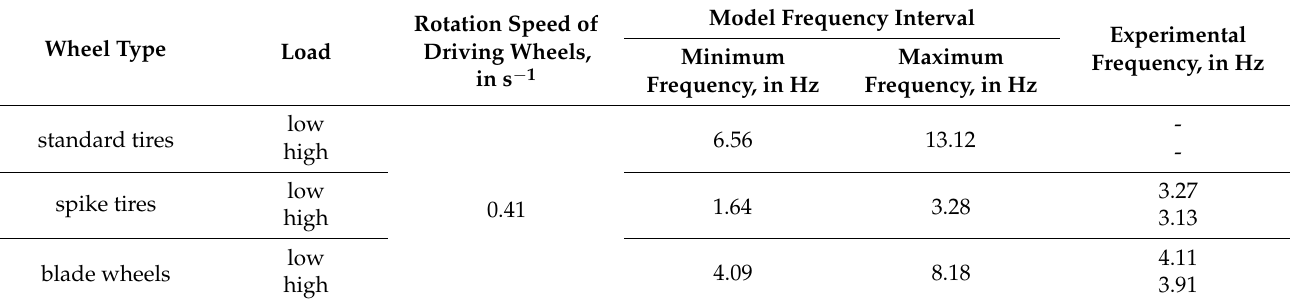
Table 4. Frequencies corresponding to the elements (tire tread pattern, blades, and spikes) of different driving wheels.